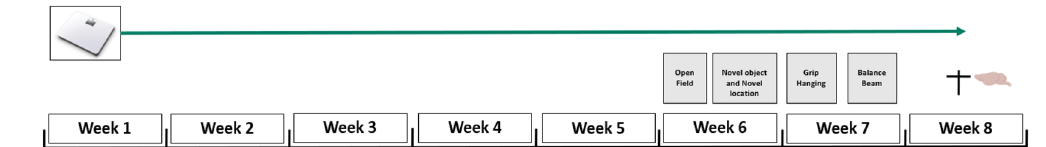
Figure 1. Experimental Design: Animals underwent five weeks of whole body vibration (WBV) intervention with either 5 or 20 min daily sessions, five times per week. After five weeks, a test battery was performed to evaluate anxiety-like behavior, memory functions and motor performance. Animals were terminated on week 8 and brain tissue was collected for immunohistological